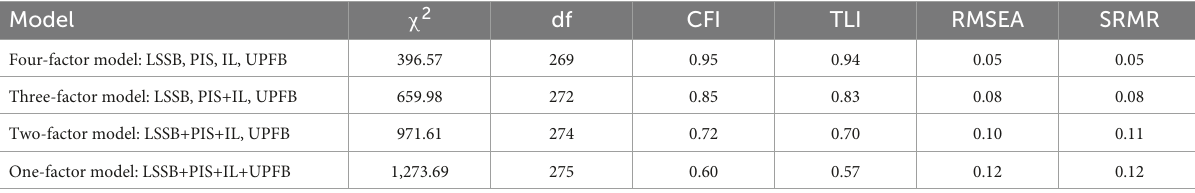
TABLE 1 Confirmatory factor analysis